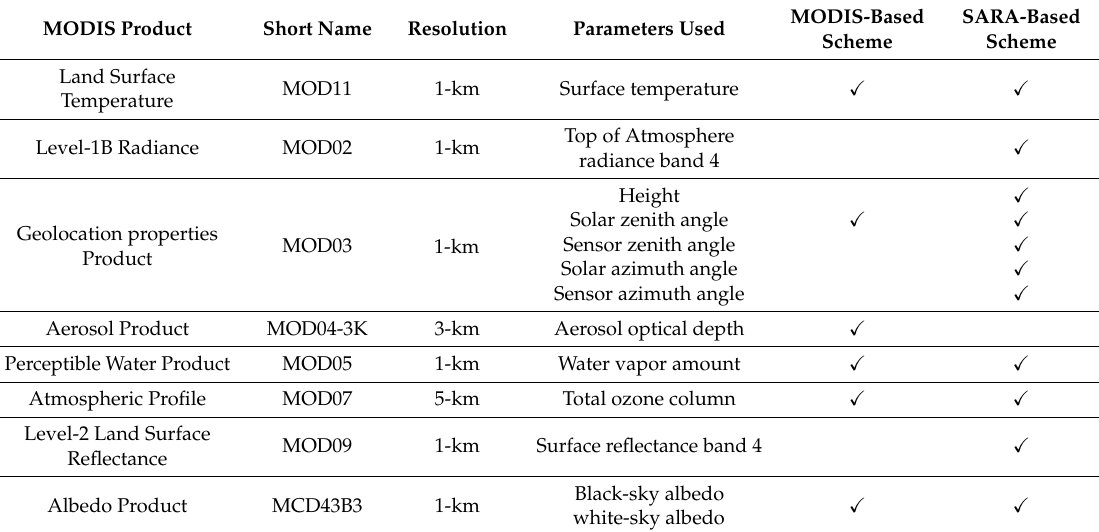
Table 1. Summary of the MODIS data products used in this study.